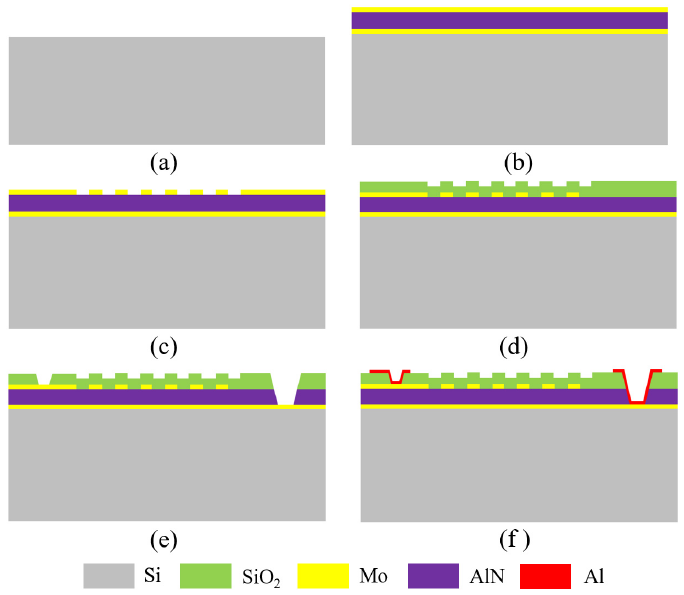
Figure 3. Process flow of the QSAW resonators. ( a ) Starting with a Si wafer, ( b ) Mo/AlN/Mo layers deposition, ( c ) Top Mo layer patterning to define IDT fingers and reflector gratings, ( d ) Top oxide deposition, ( e ) Contact vias opening to access the top and bottom electrodes, ( f ) Al deposition and patterning to form the bonding pads and connection lines.